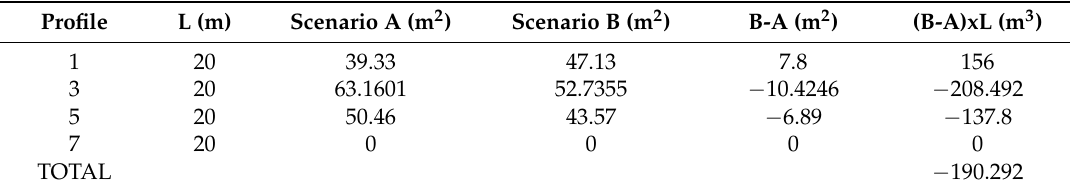
Table 1. Volumetric change data based on the representative profiles. Four profiles were extracted, and they were separated by 20 m (L). Areas were measured following the procedure shown in Figure 4, with respect to an arbitrary reference level. Zero values mean that no changes were detected in the corresponding profile. Volumes were calculated by multiplying the area measured in the profile by the separation between profiles (L).